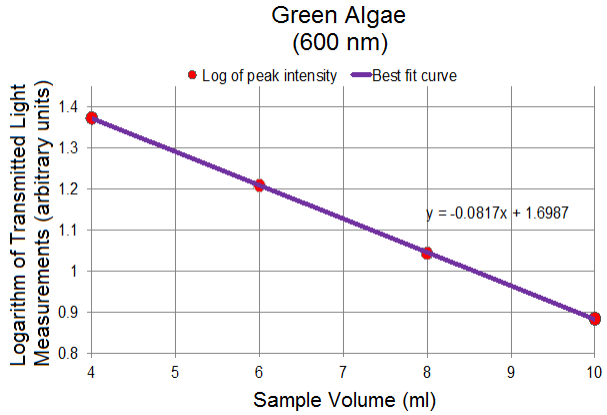
Figure 9. Logarithm of transmitted light intensity (reported in digital numbers) at 600 nm for 4, 6, 8 and 10 mL samples, demonstrating a linear decrease with linearly increasing algae sample volume. Gradient can be used to compute the absorptivity in respective